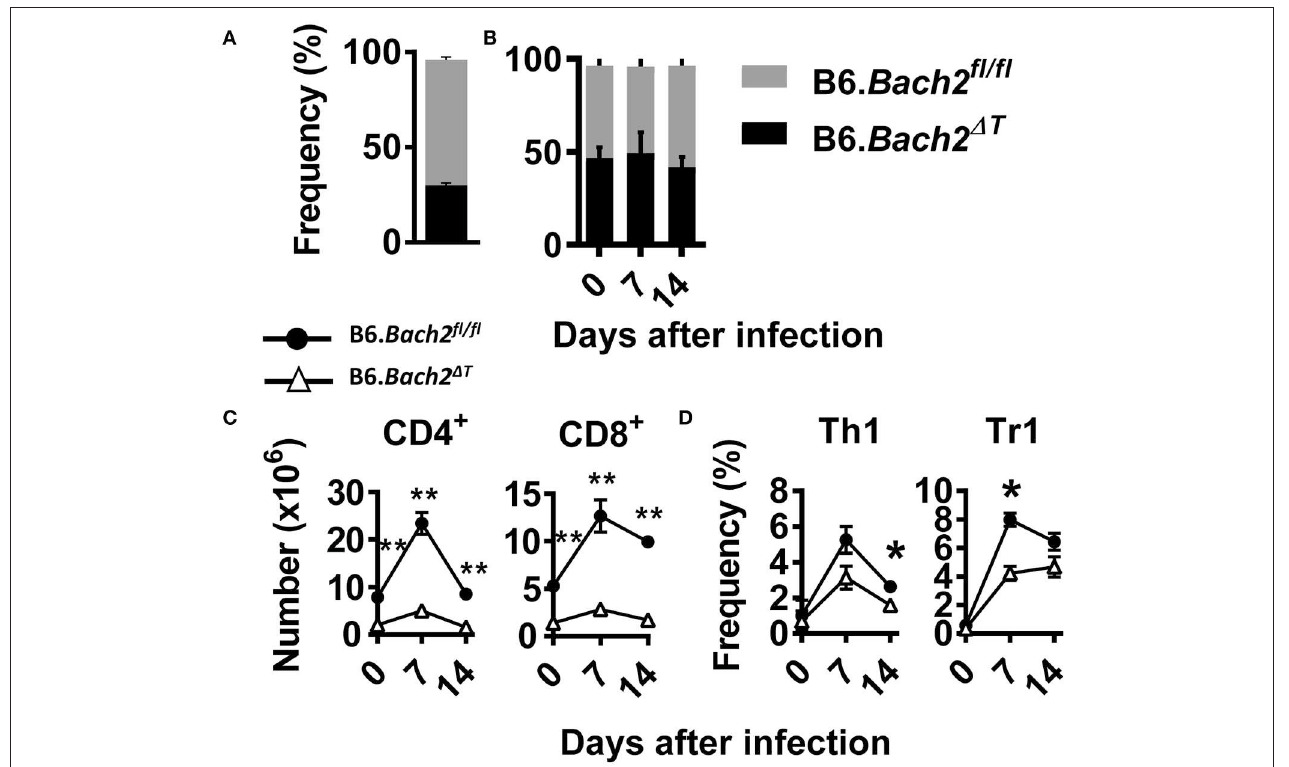
FIGURE 4 | Cell intrinsic BACH2 supports T cell development and expansion. B6. Bach2 ∆ T (CD45.2):B6. Bach2 fl / fl (CD45.1) (50:50) mixed bone marrow chimeric mice were generated in lethally irradiated B6. Rag1 − / − mice and engraftment measured in splenic leukocytes 12 weeks later (A) . Subsequently, these mice were generated by injecting a 70:30 mix of bone marrow from B6.Bach2 ∆ T and B6. Bach2 fl / fl mice into irradiated B6. Rag1 − / − mice, and the proportions of CD45.2 and CD45.1 leukocytes in the spleen were measured before P. chabaudi infection and 7 and 14 days p.i., as indicated (B) . Numbers of CD4 + T and CD8 + T cells (C) , as well as frequency of Th1 and Tr1 cells (D) in the spleen at days 0, 7, and 14 p.i., as indicated, were measured by flow cytometry. n = 6 mice per group per time point. Mean ± SEM, * P < 0.05, ** P < 0.01, significance assessed by Mann-Whitney